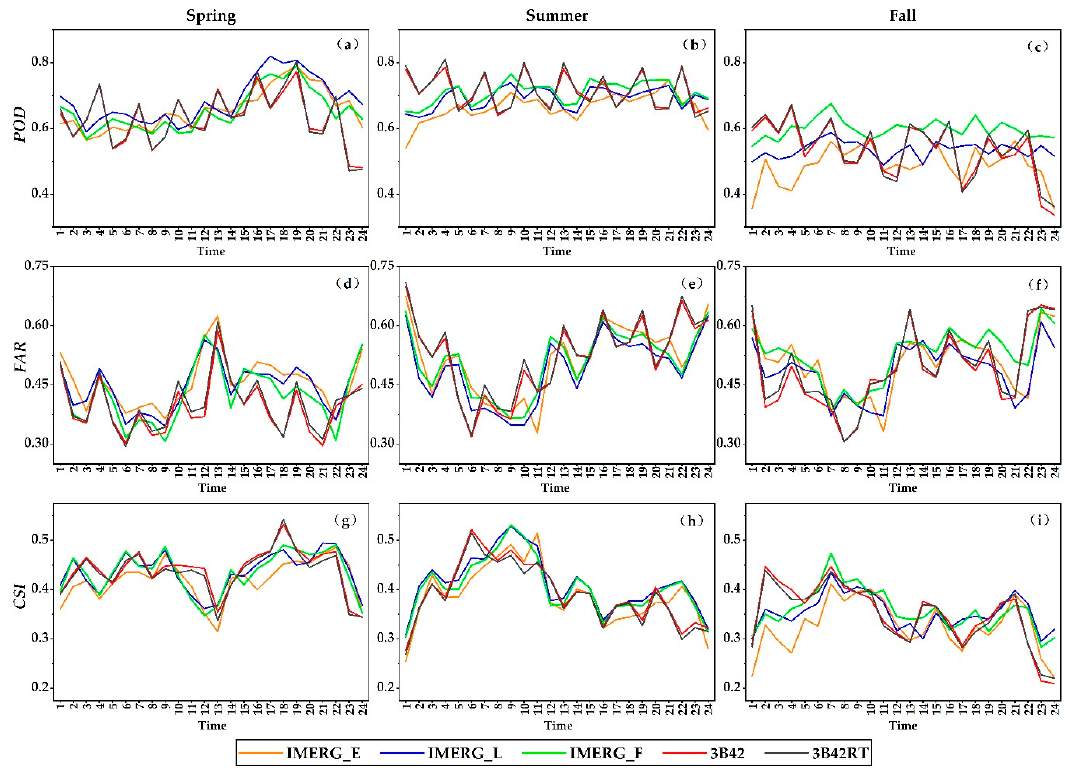
Figure 10. Changes in mean categorical metrics over a diurnal cycle in three seasons: ( a ) POD in spring; ( b ) POD in summer; ( c ) POD in fall; ( d ) FAR in spring; ( e ) FAR in summer; ( f ) FAR in fall; ( g ) CSI in spring; ( h ) CSI in summer; and ( i ) CSI in fall.